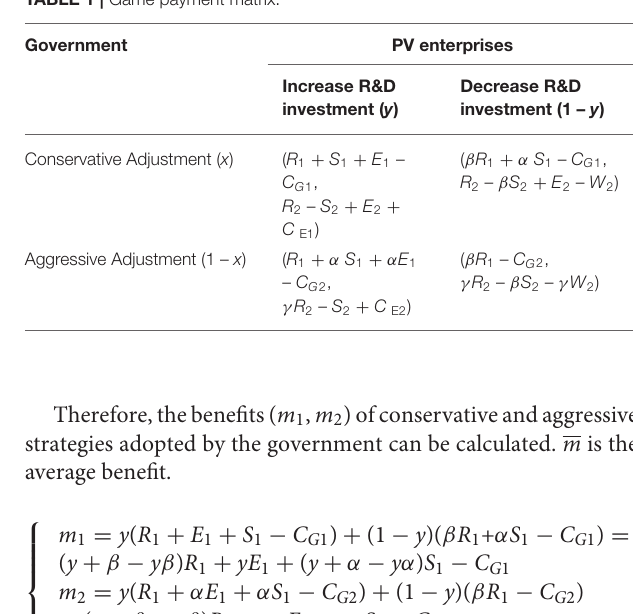
TABLE 1 | Game payment